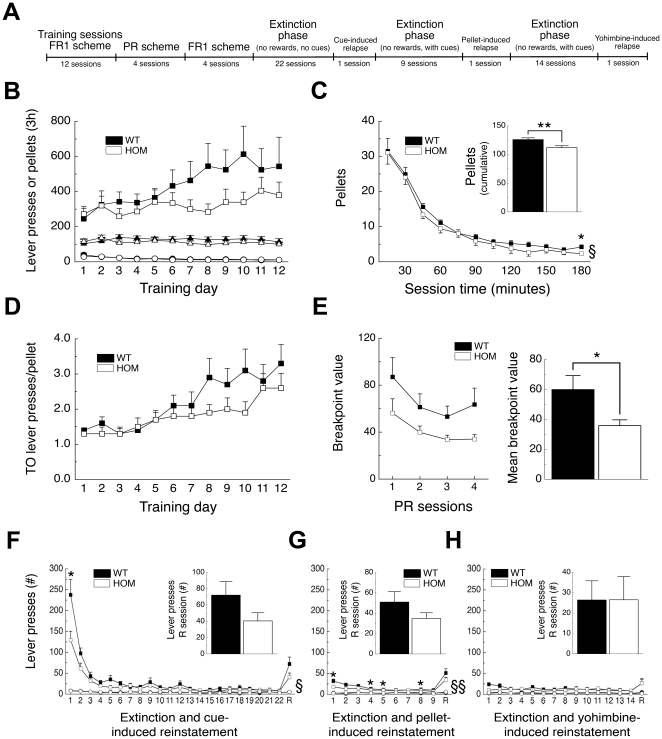

Pmch
−/− rats show decreased HF food-reinforced operant responding for 45% fat pellets.(A) Experimental timeline for HF food-reinforced operant responding paradigm. (B) Number of total active-lever presses (squares), total inactive-lever presses (circles), and total number of pellets (triangles) during training sessions over 12 alternating days (one 3 hr session per day, every other day). (C) Mean pellets earned during 12 training sessions (total per 15-min bin time course) or per 3 hr (inset). (D) Total number of time-out (TO) presses per pellet during training sessions. (E) Breakpoint values of progressive ratio (PR) sessions over 4 alternating days (one 3 hr session per day, every other day), and mean breakpoint value of the last 3 PR sessions. Number of total active-lever presses (squares) and total inactive-lever presses (circles) during extinction sessions before (F) cue-induced (22 extinction sessions), (G) pellet-induced (9 extinction sessions), or (H) yohimbine-induced (14 extinction sessions) reinstatement (R, reinstatement session) of food seeking. Inset shows R session enlarged (n = 10 per group). §, P<0.05, §§, P<0.005, WT vs. HOM, repeated-measures ANOVA; *P<0.05, **P<0.005, Students' t-test. Data are shown as mean ± S.E.M.